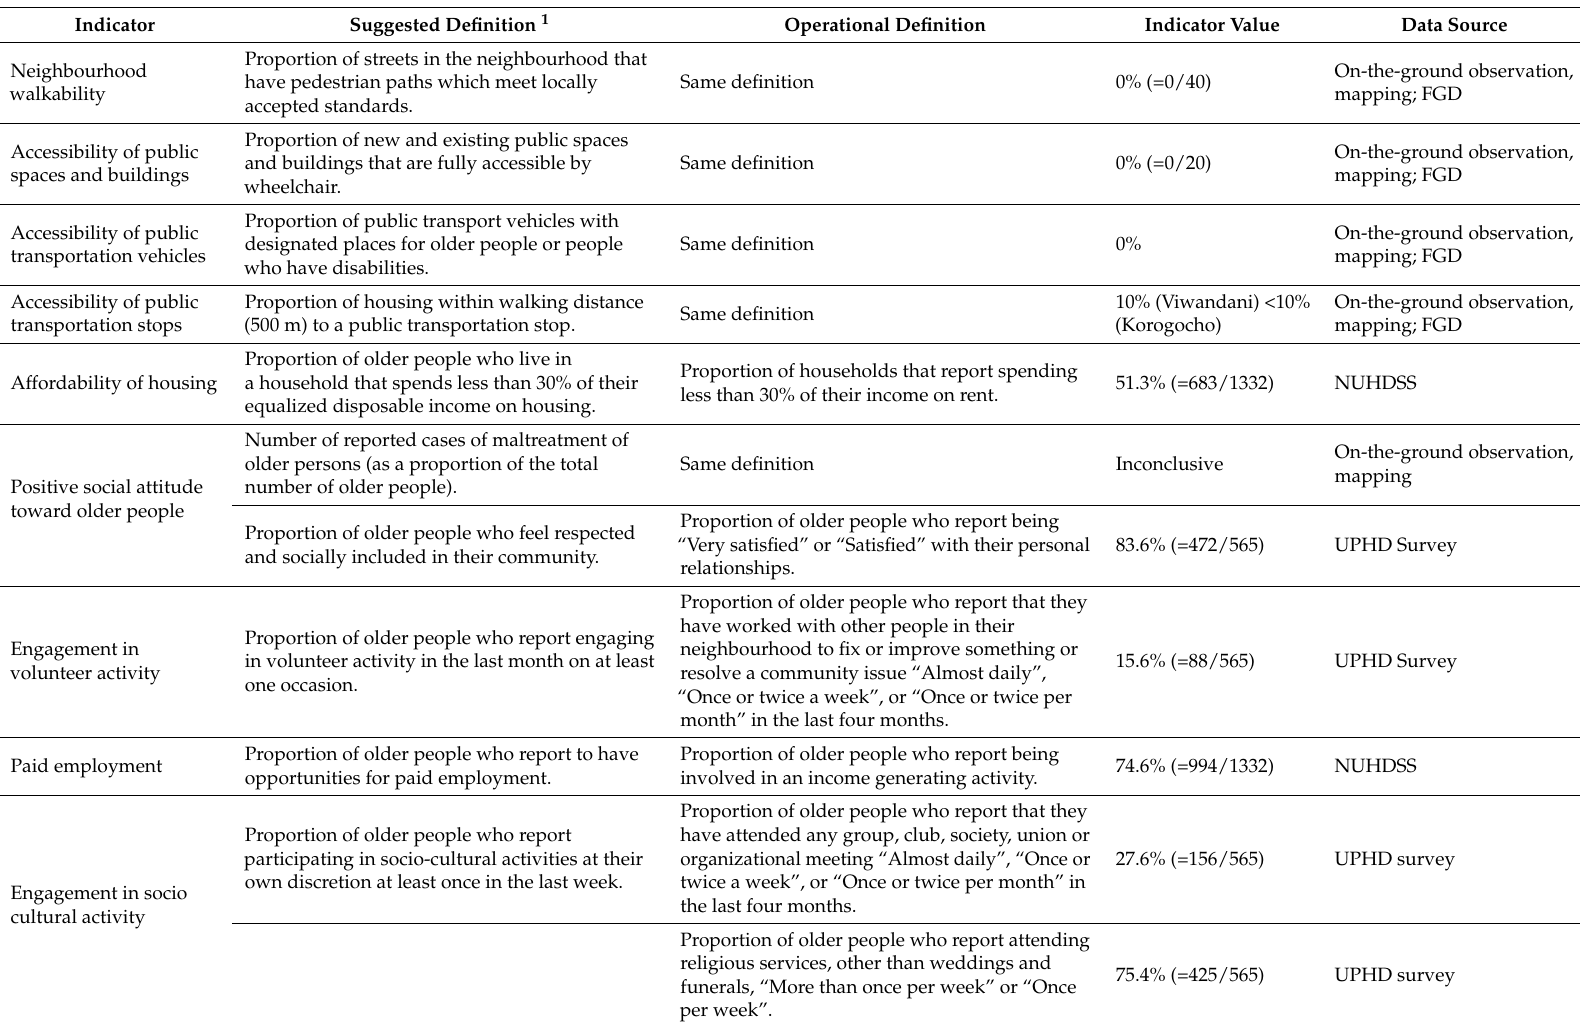
Table 1. Age-friendly city core indicator assessment in Korogocho and Viwandani, Nairobi, Kenya, 2015.